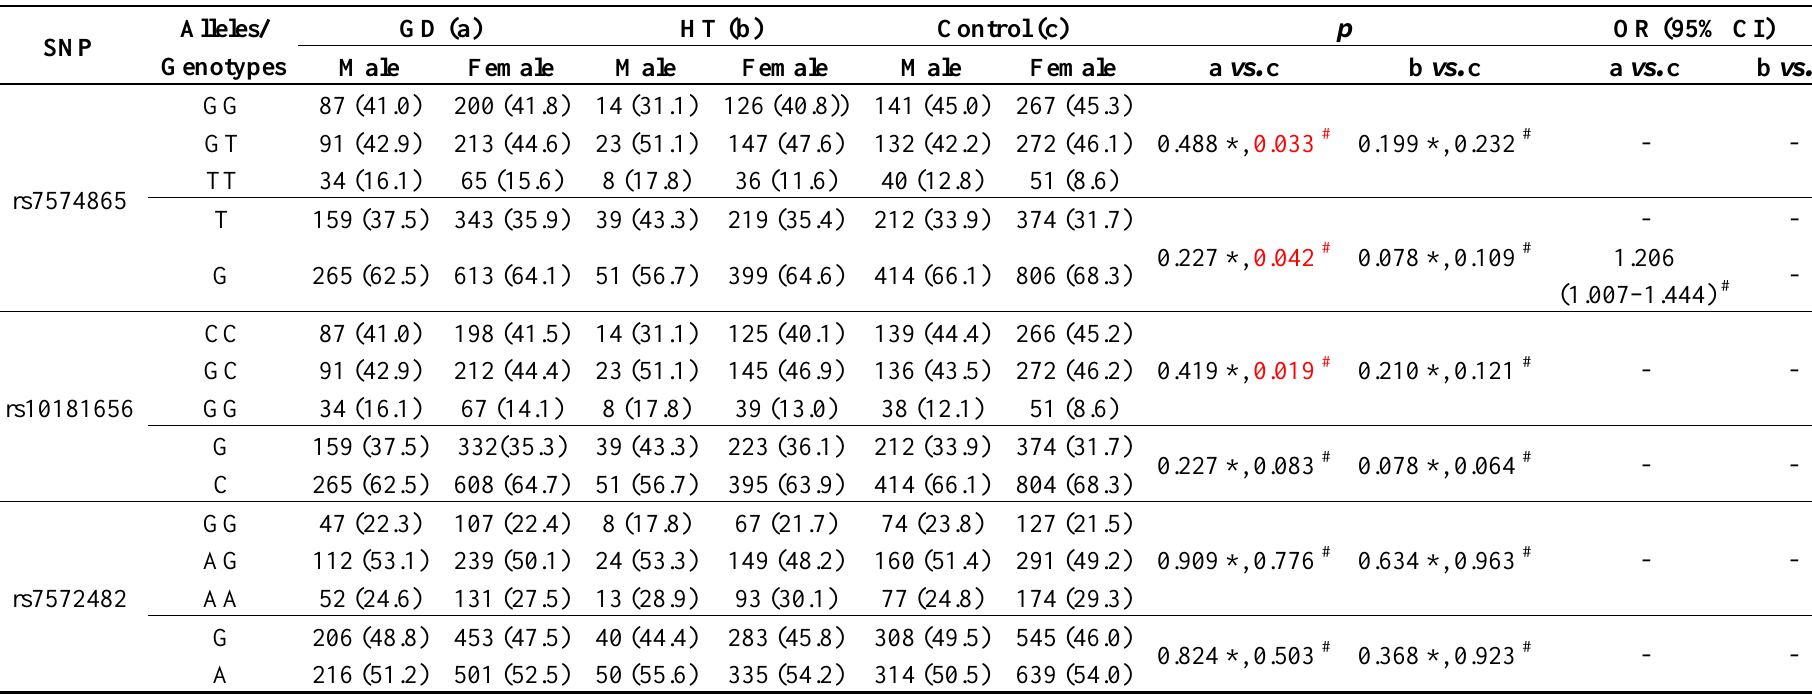
Table 4. Analysis of genotype and allele distribution of three STAT4 SNPs in GD, HT patients and controls after gender stratification. * Male; # Female. The red font stands for the genotype and allele distribution of three STAT4 SNPs in female GD, HT patients and female